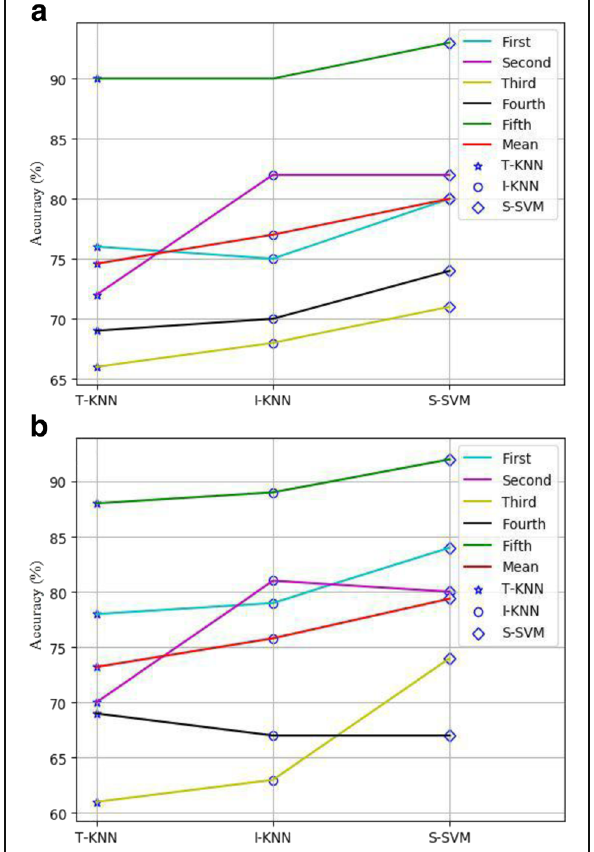
Fig. 8 Comparison of accuracy of recognition for three algorithms. a Accuracy in 14-dimensional feature space. b Accuracy in 2-dimensional feature space. The legends first, second, third, fourth, fifth, and mean, respectively, represent the first gesture, the second gesture, the third gesture, the fourth gesture, the fifth gesture, and mean of five types of gestures. T-KNN represents the traditional KNN algorithm, and I-KNN represents the improved KNN algorithm. S-SVM represents the soft margin SVM